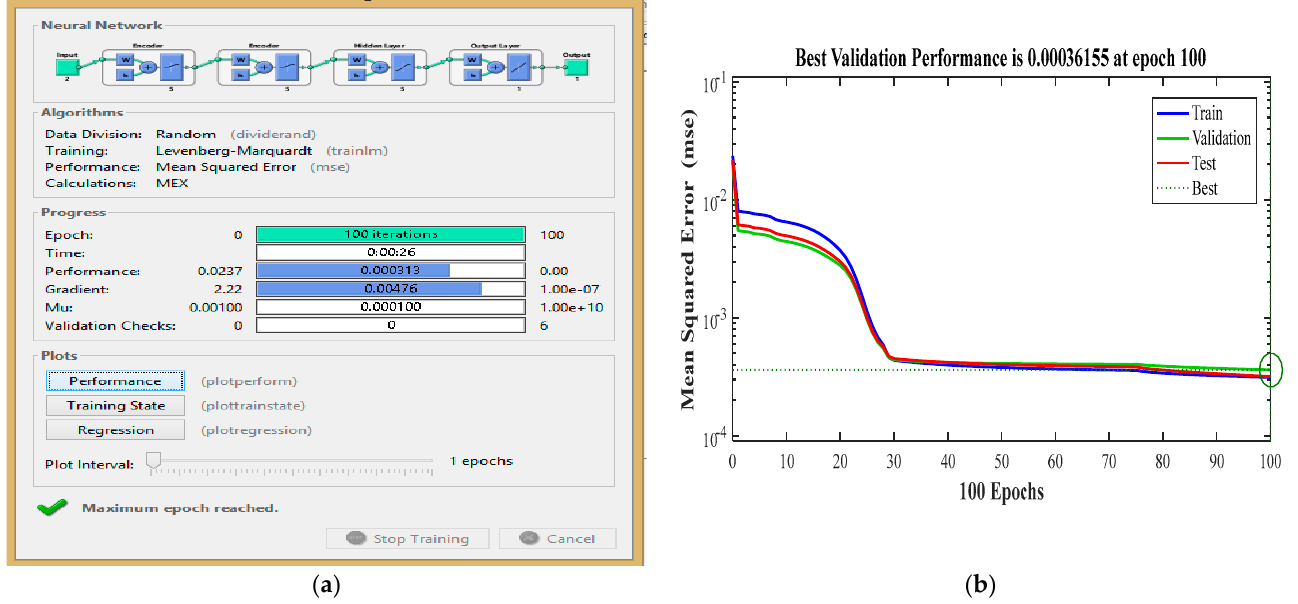
Figure 9. ANN learning progress of active power controller and its evolution training, ( a ) training GUI, ( b ) training performance based on MSE.